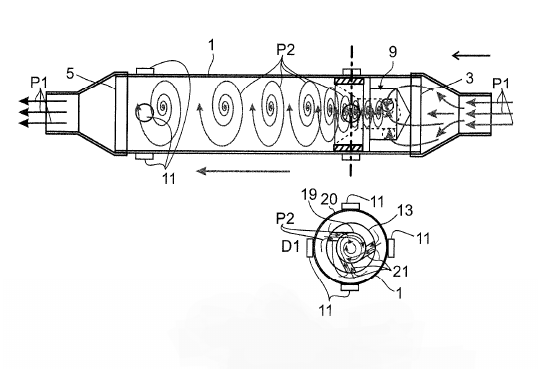
Figure 4. The EVOdrop turbine operation principle. Figure 5 illustrates the EVOdrop filter.